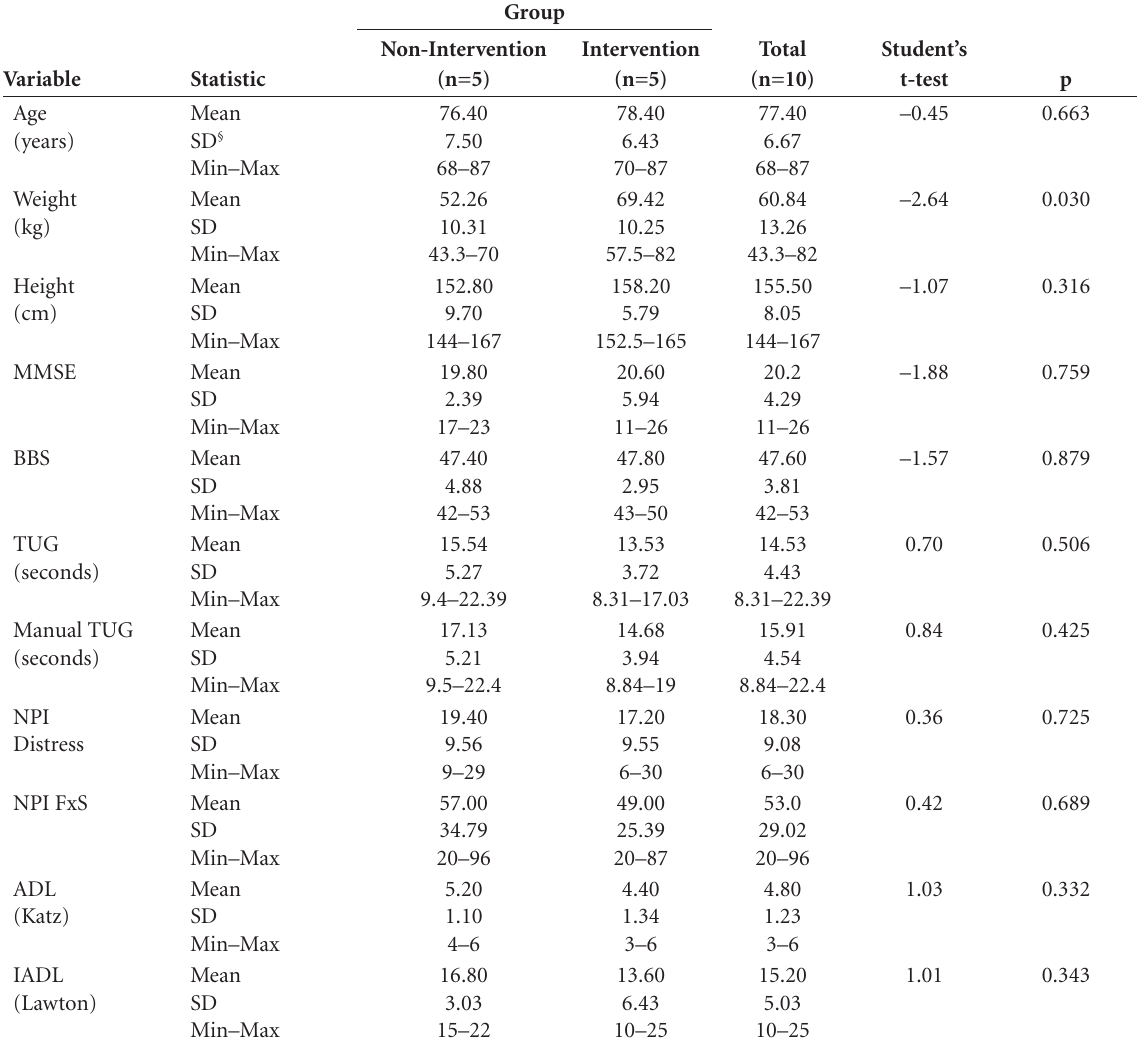
Table 2. Summary statistics of continuous variables for intervention and non-intervention groups at